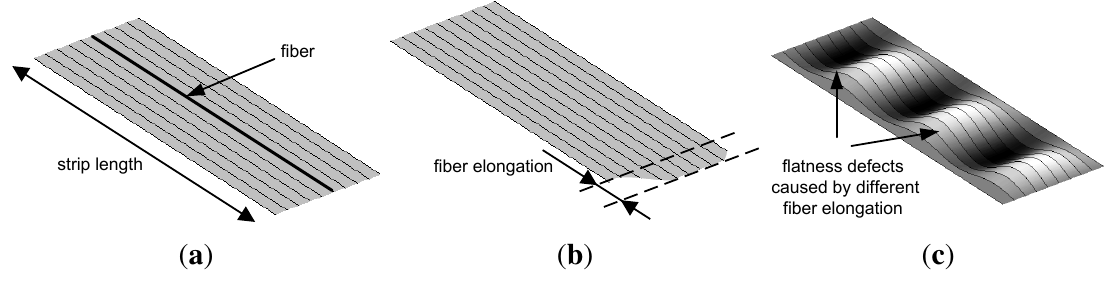
Figure 2. Flat-rolled product considered as multiple, adjacent longitudinal fibers: ( a ) rolled product after rolling with all fibers featuring the same length; ( b ) theoretical model of a product showing different fiber length; ( c ) realistic model of a rolled product after rolling showing flatness defects, due to different fiber